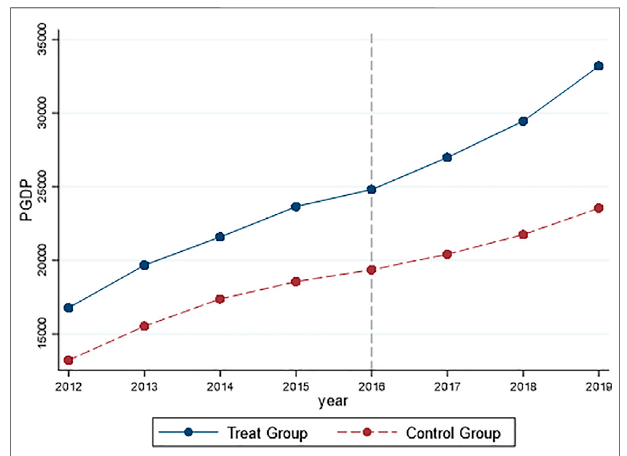
FIGURE 3 | Per capita GDP in poverty-stricken counties.